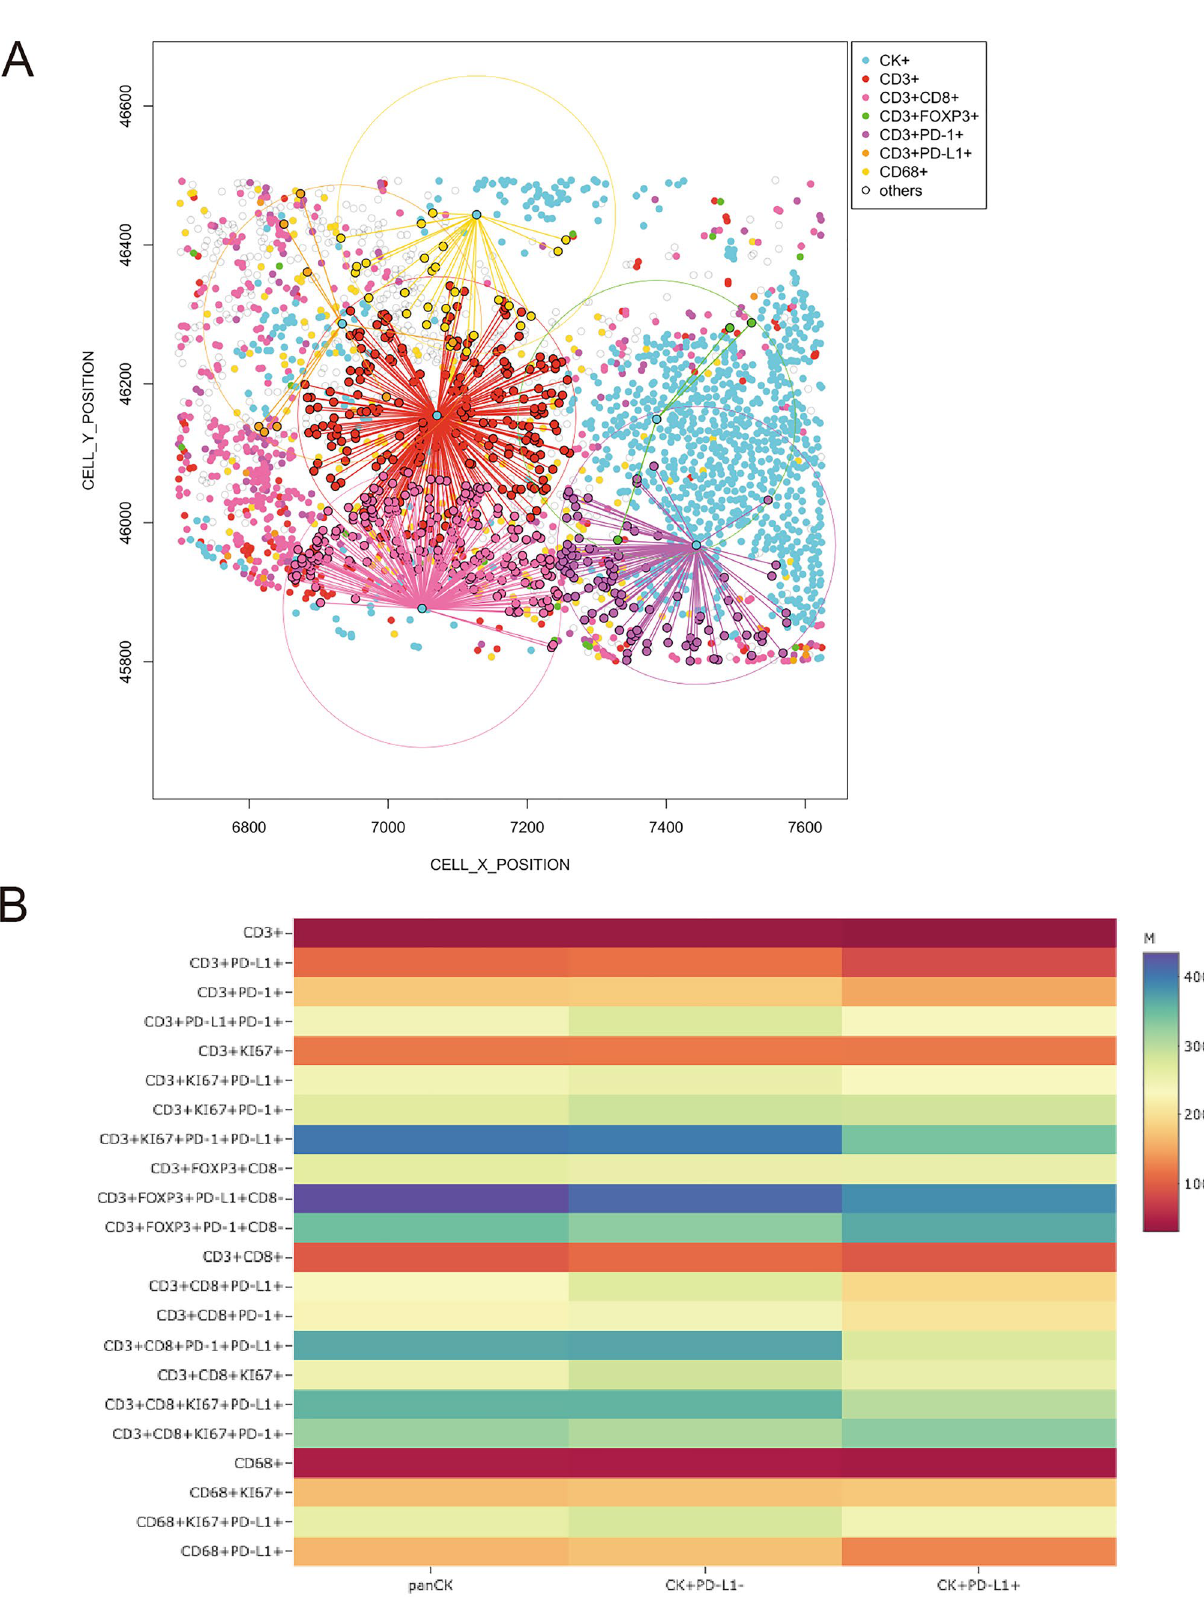
Figure 4. Spatial analysis showing, ( A ) e representative examples of distance measurements from malignant cells (panCK +) to different T-cells CD3 + phenotypes using the X and Y coordinate; ( B ) head map showing the relative proximity from panCK + cells, first column ; panCK + cells that not expressing PD-L1, second column ; and panCK + cells that expressing PD-L1, third column, to a variety tumor associated immune cell phenotypes in the malignant pleural mesothelioma cases. The images were generated using R studio software version